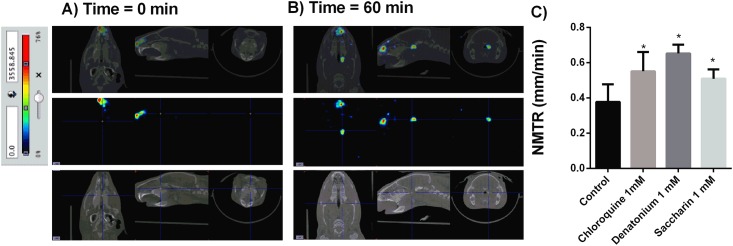
Nasal mucociliary transport rate (NMTR) measurement with combined micro-CT-SPECT macroaggregated albumin (MAA)-Technetium 99 metaestable (Tc99m) in guinea pig.A) MAA-Tc99m traveled distance at time 0. B) MAA-Tc99m traveled distance after 60 min of nasal administration. C) Bitter taste receptor agonists chloroquine, denatonium and saccharin were aerosolized during 10 min before nasal MAA-Tc99m administration and the distance traveled during 60 min was monitored. Nasal mucociliary transport rate was calculated as mm/min. Representative images of n = 9 guinea pig per condition are showed. Colorimetric intensity scale adjusted for all images is shown. Results are expressed as mean ± SD. One-way repeated measures analysis of variance (ANOVA): P<0.001. Post hoc Bonferroni test: *P<0.001 compared with controls.